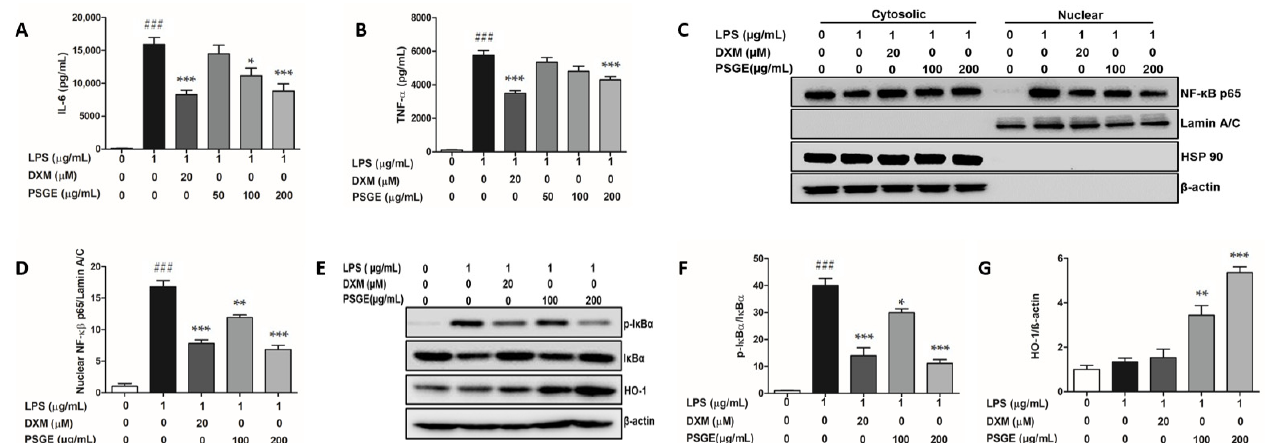
Figure 3. Effects of PSGE against LPS-induced IL-6, TNF- α cytokine expression, and NF- κ B signaling in RAW 294.7 cells. Production of ( A ) IL-6 and ( B ) TNF- α levels were measured by ELISA. RAW 264.7 cells were pre-treated with indicated concentration of PSGE or DXM for 2 h followed by LPS for 24 h. ( C ) Western blot analysis of nuclear and cytosolic fractions using NF- κ B p65 antibody, ( D ) quantitative analysis of nuclear NF- κ B p65 relative to Lamin A/C, ( E ) Protein expression and quantitative analysis of ( F ) p-I κ B α relative to I κ B α and ( G ) HO-1 relative to β -actin. RAW 264.7 cells were pretreated with the indicated concentrations of PSGE and DXM for 2 h followed by LPS for 2 h. Lamin A/C and HSP90 were used as cytosolic and nuclear markers. DXM as positive control. Data shown represent mean ± SEM ( n = 3). (### p < 0.001 vs. control; * p < 0.05, ** p < 0.01, and *** p < 0.001 vs.